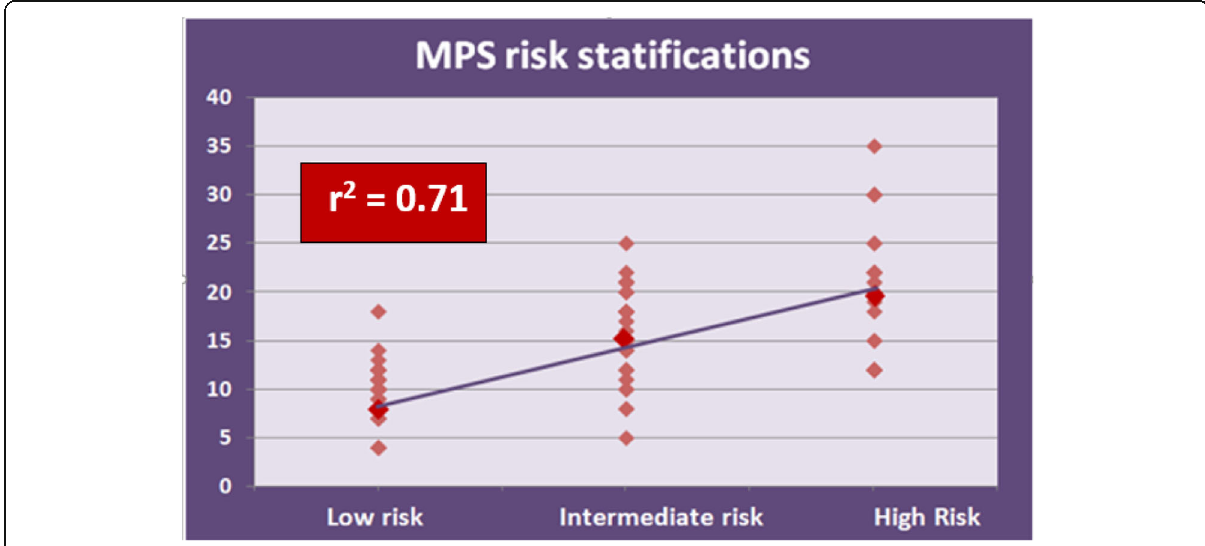
Fig. 3 GWR correlation with MPS